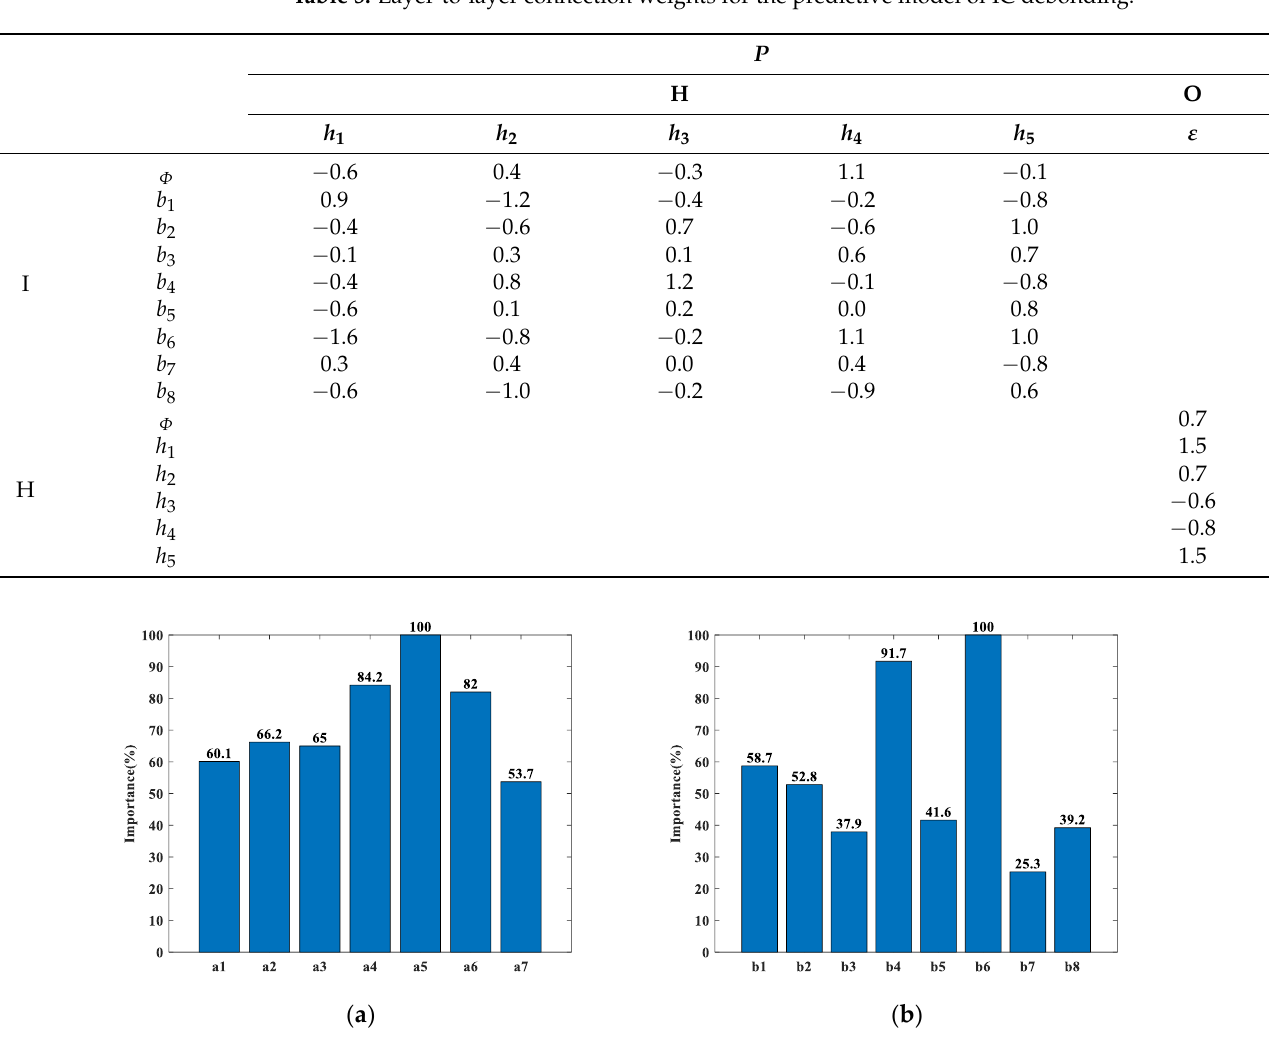
Table 5. Layer-to-layer connection weights for the predictive model of IC debonding.